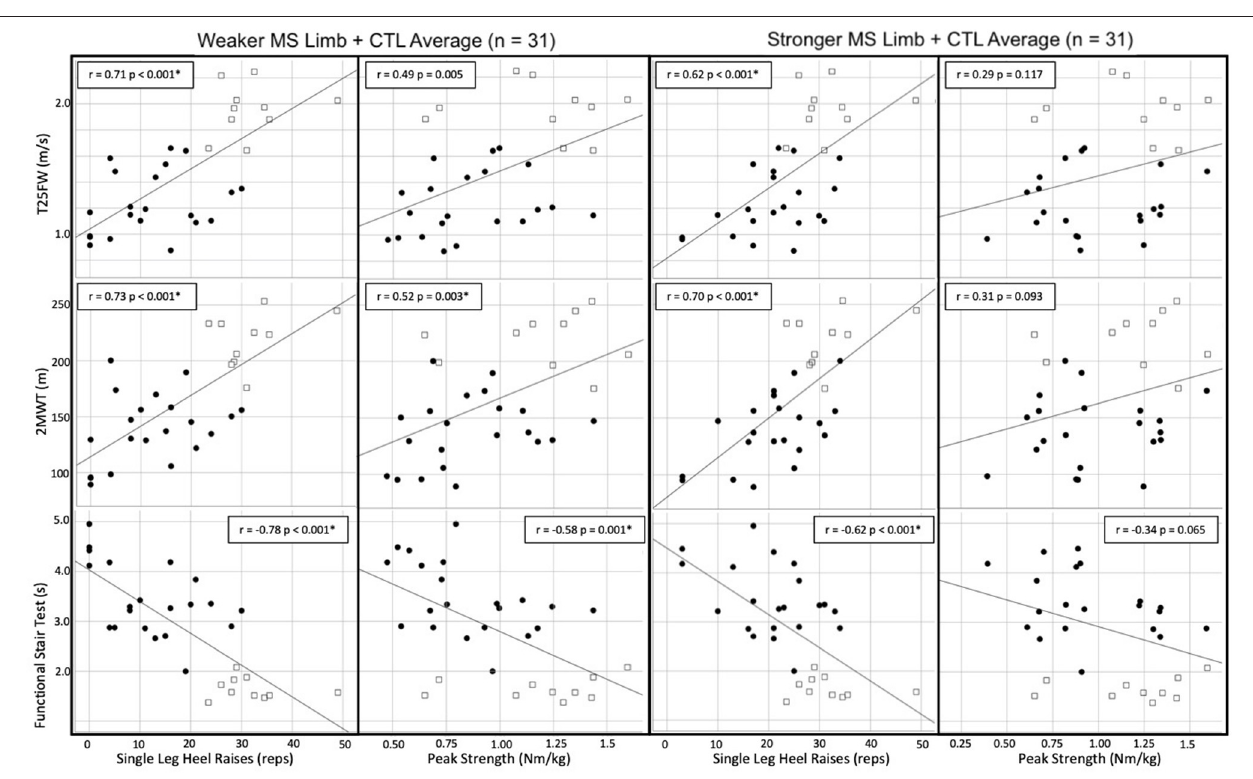
FIGURE 2 | Scatter plots and Pearson values for ankle plantarflexion muscle performance measures to functional mobility. • = participants with MS; 2 = healthy control. *Significant based on Bonferroni corrected α = 0.05/12 = 0.004. T25FW, timed 25-foot walk; 2MWT, 2-min walk test; FST, functional stair